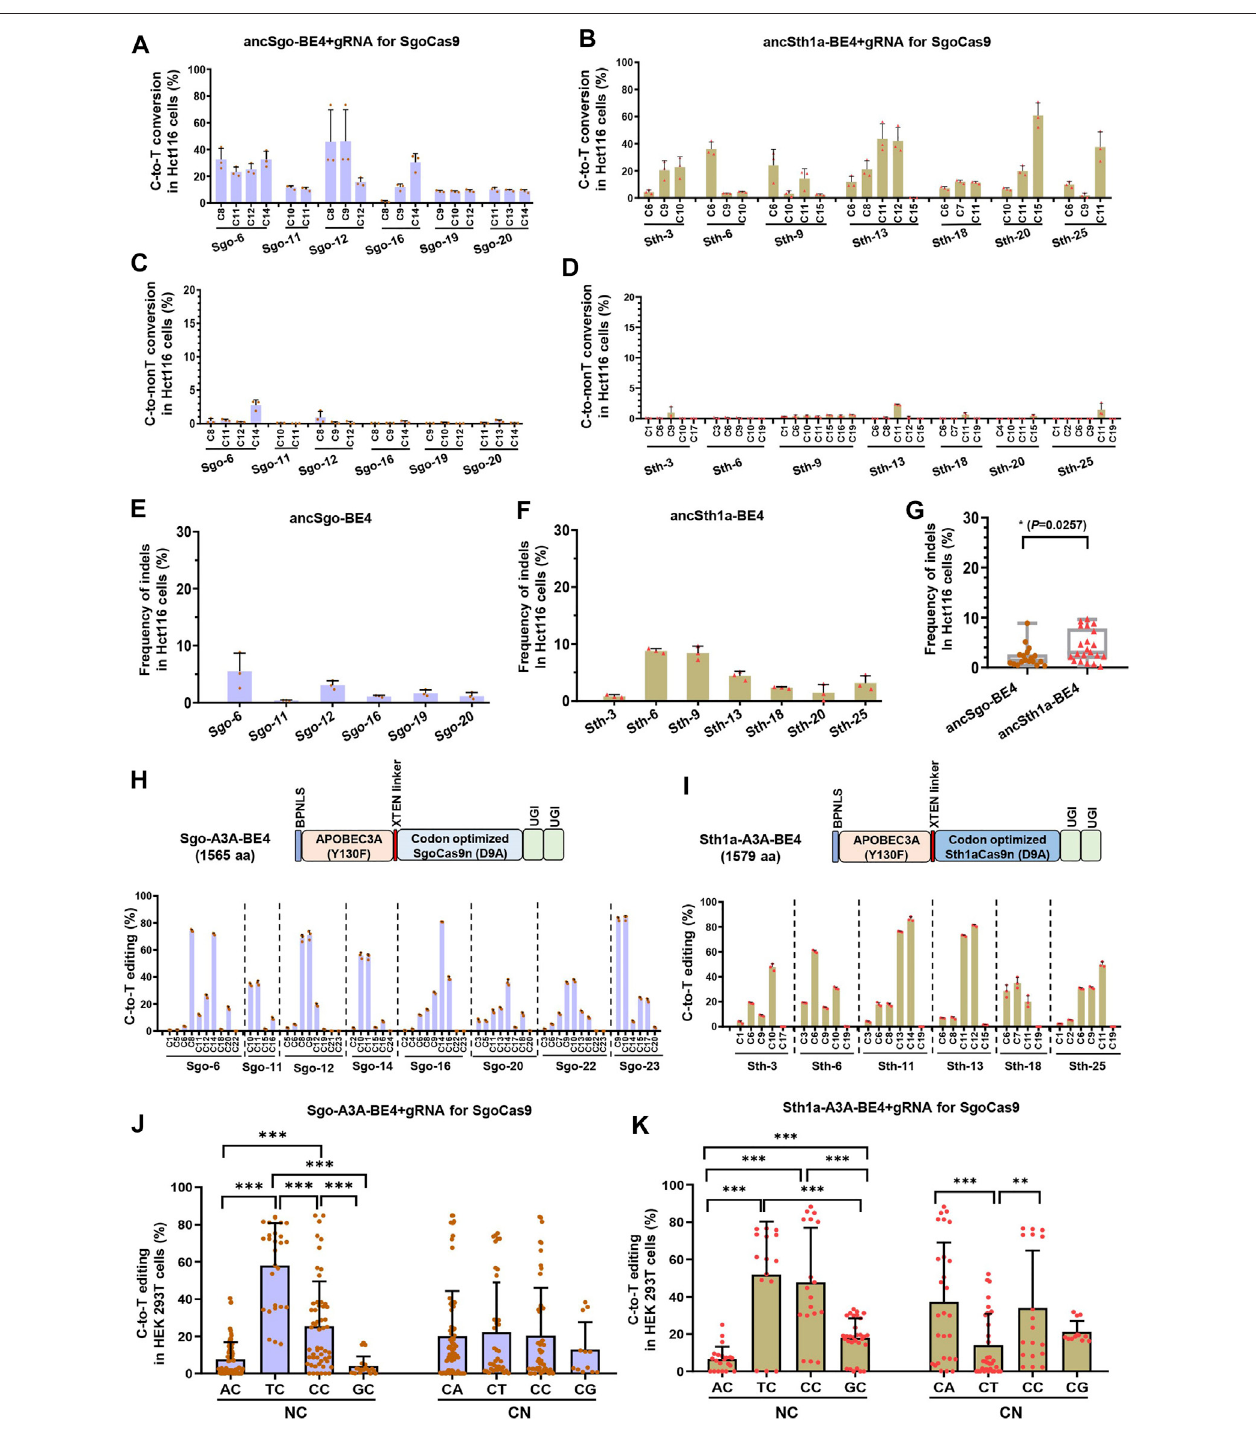
FIGURE 3 | Editing universality of ancSgo-BE4 and ancSth1a-BE4 in human cells and the editing capability of APOBEC3A-mediated CBEs. (A – F) The C-to-T conversionef fi ciencies (A,B) ,C-to-non-Tconversionef fi ciencies (C,D) ,andthefrequenciesofindels (E,F) inducedbyancSgo-BE4andancSth1a-BE4attargetingsites in Hct116 cells were presented. (G) Comparison offrequencies ofindels in E and F from Hct116 cells. P -value was calculated from unpaired, two-tailed Student ’ s t-test (* p < 0.05). (H,I) The schematic diagram showingthe plasmid architecturesofSgo-A3A-BE4and Sth1a-A3A-BE4 (H) (upper panel) and C-to-T editing ef fi ciencies inducedbySgo-A3A-BE4andSth1a-A3A-BE4inHEK293Tcells(lowerpanel) (I) . (J,K) ComparisonofC-to-TeditingactivitiesinducedbySgo-A3A-BE4 (J) andSth1a- A3A-BE4 (K) in different neighboring contexts at the 5 ’ (NC) or 3 ’ (CN) ends of targeted cytosines (Student ’ s t-test). ** p < 0.01, *** p < 0.001.